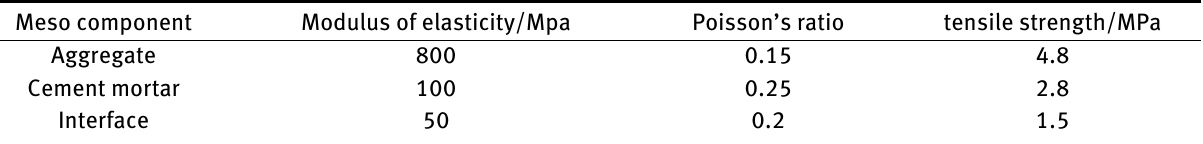
Table 2: CSG micro component parameter table Meso component